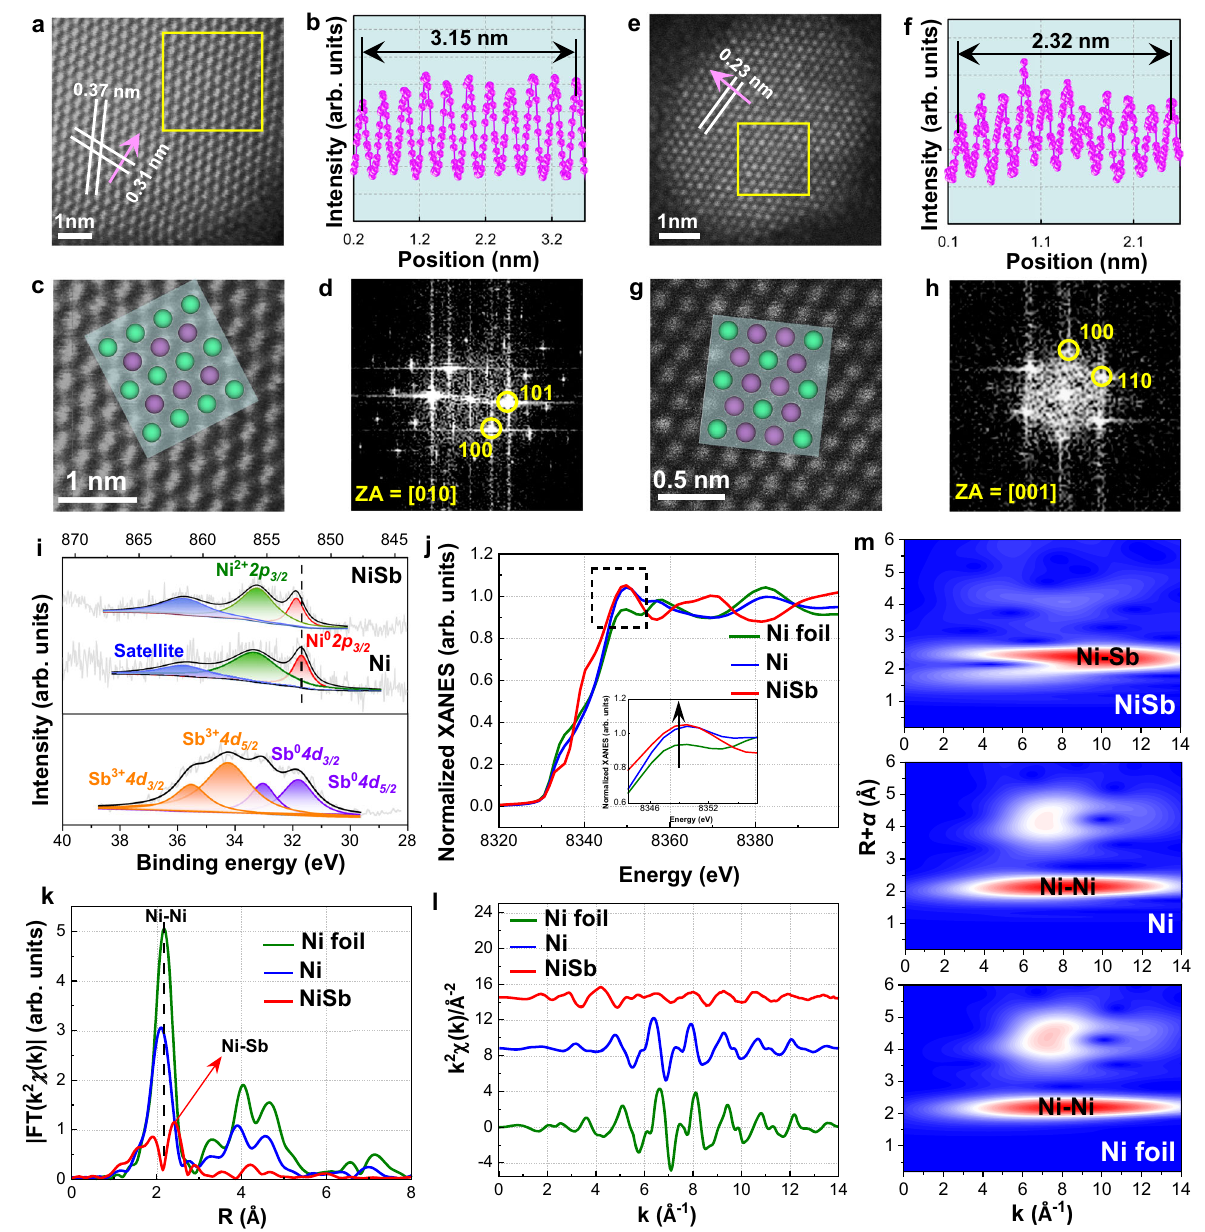
Fig. 4 | Atomic structures ofNiSb intermetallic catalyst. a , e Representative AC- HAADF-STEM images of NiSb catalyst along with different zone axes. b , f Line intensitypro fi lesalongdirectindicatedbythevioletarrowsin a and e . c , g Enlarged views of the areas marked by the yellow rectangles in a and e as well as the cor- responding crystalmodels along with [010]and [001] zones, respectively. d , h The